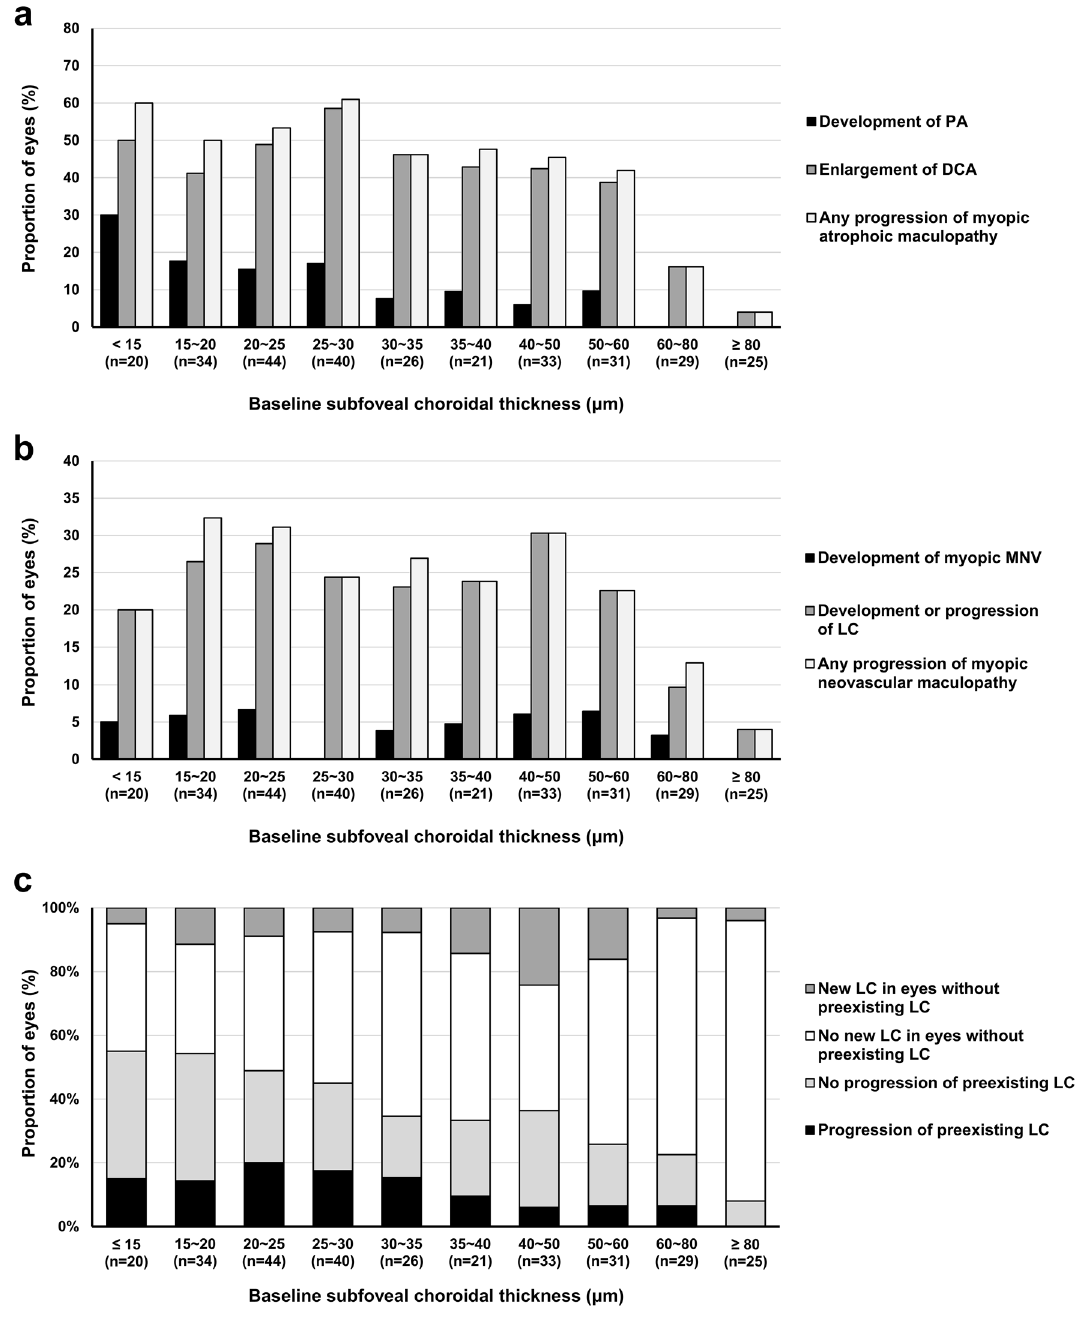
Figure 3. Frequency of myopic atrophic maculopathy progression during follow-up (a) , myopic neovascular maculopathy progression during follow-up (b) , and prevalence of LC at baseline and change of LC during follow-up (c) according to the baseline subfoveal choroidal thickness. PA = patchy atrophy; DCA = diffuse chorioretinal atrophy; myopic MNV = myopic macular neovascularization; LC = lacquer